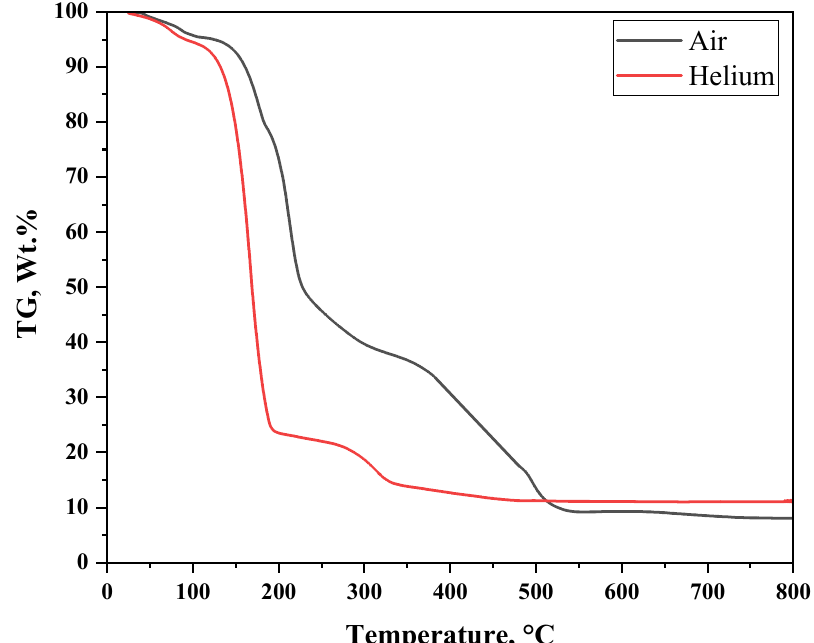
Figure 9. TGA analyses of (C 6 H 11 NH 3 ) 4 [Ni(NCS) 6 ] · 2H 2 O under air (black) and helium (red).